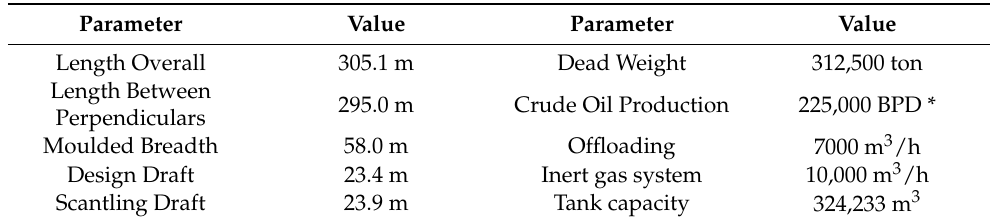
Table 2. FPSO specification [31].